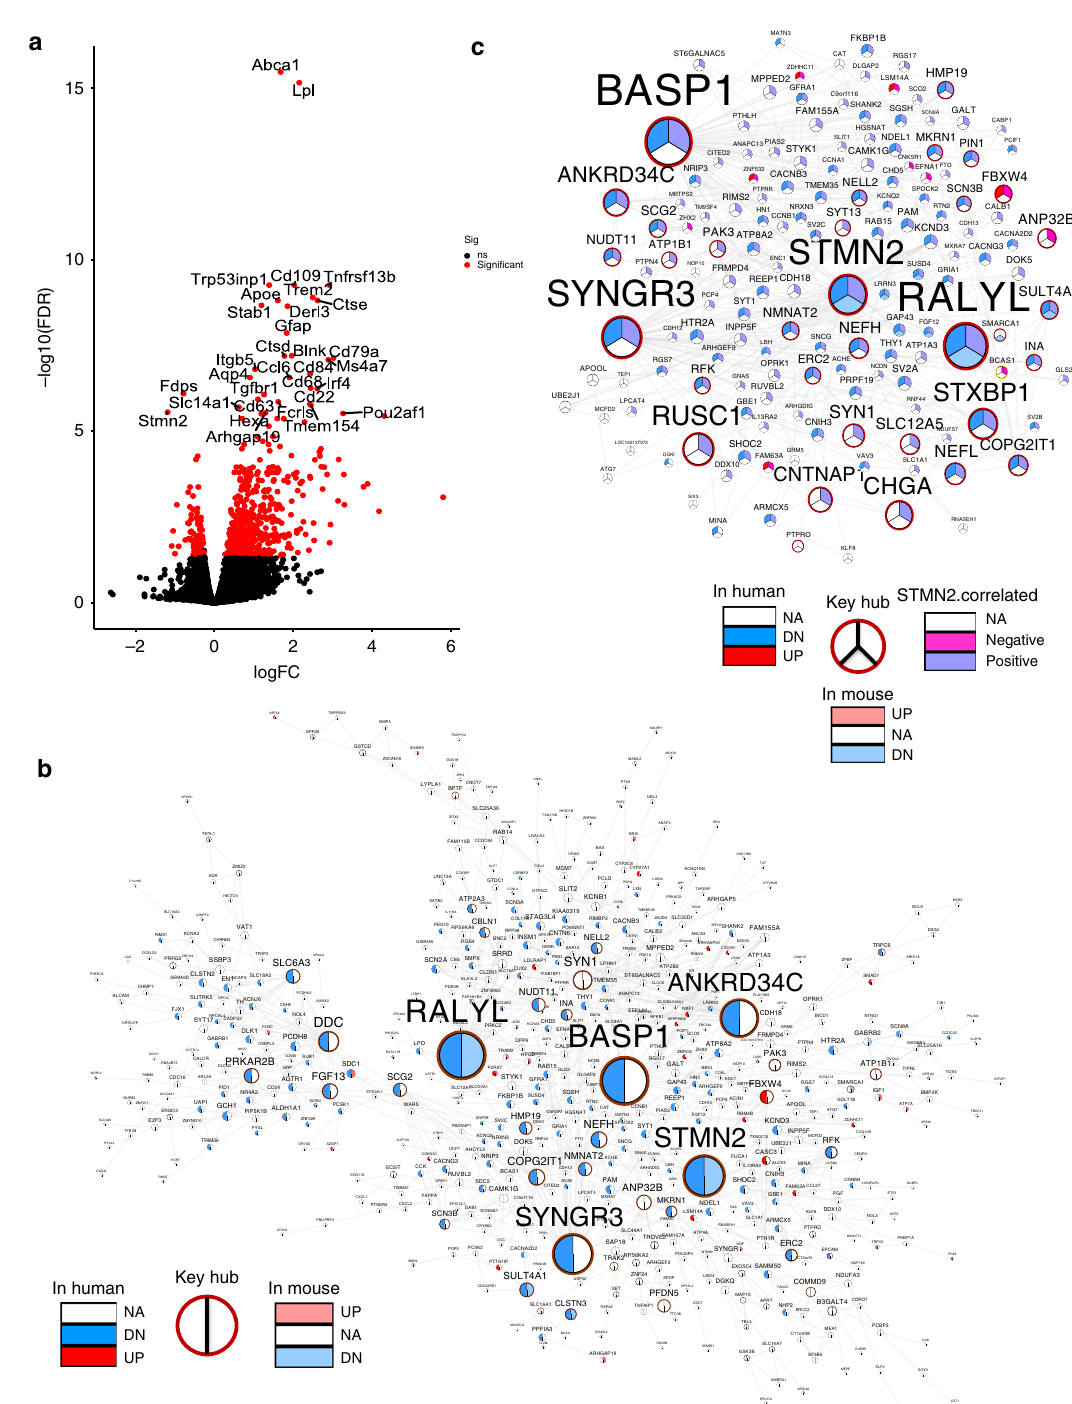
Fig. 4 Validation of the PD MEGENA network by Stmn2 perturbation. a Volcano plot shows genes that are signi fi cantly differentially expressed in the midbrain between the mice received scrambled AAV and Stmn2 -shRNA AAV. b The genes in M4 are signi fi cantly enriched for the downregulated DEGs identi fi ed in the midbrain of the Stmn2 knockdown mice. Nodes with burgundy labels are key hubs of M4. The left-side half circle of each node indicates the DEGs in human between the PD and control groups while the right-side represents the DEGs in mice by Stmn2 knockdown. c The two-layer network neighborhood of STMN2 is signi fi cantly enriched for the DEG downregulated by Stmn2 knockdown. Nodes with burgundy labels are key hubs in the MEGENA network. The left upper part of the circle represents the DEG in human between the PD and control groups while the right upper part of the circle represents the correlation with STMN2 in PD patients. The bottom part of the circle indicates the DEGs in mice by Stmn2